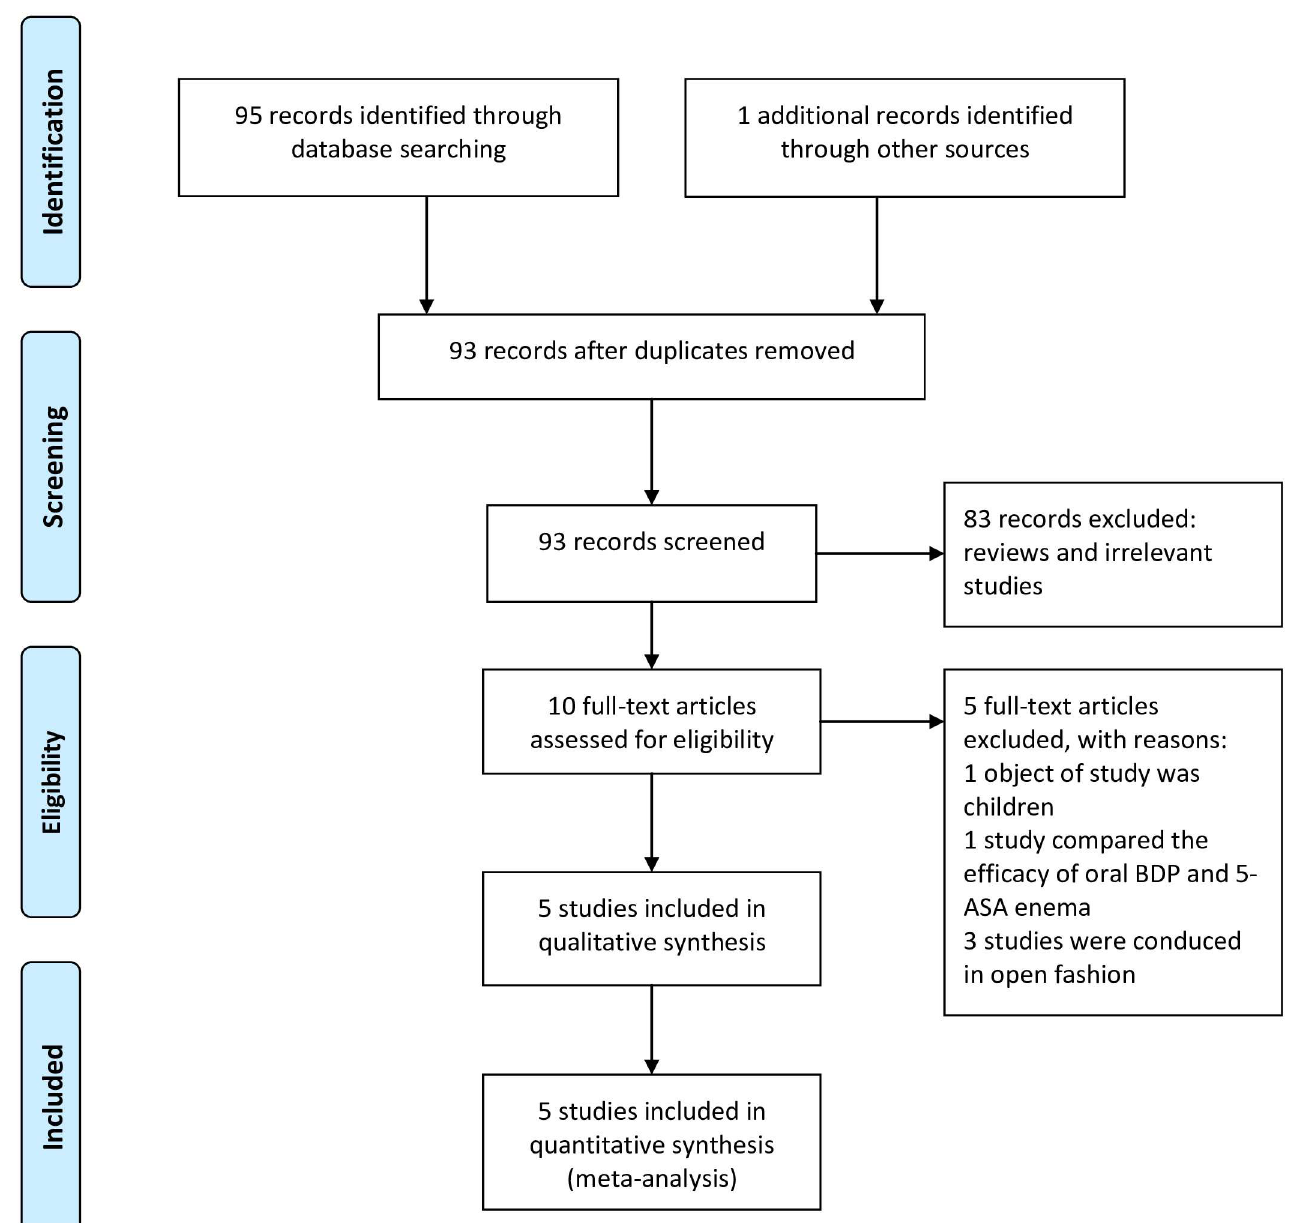
Fig 1. Flow diagram for selection of randomized controlled trials (RCTs) included in the meta-analysis.